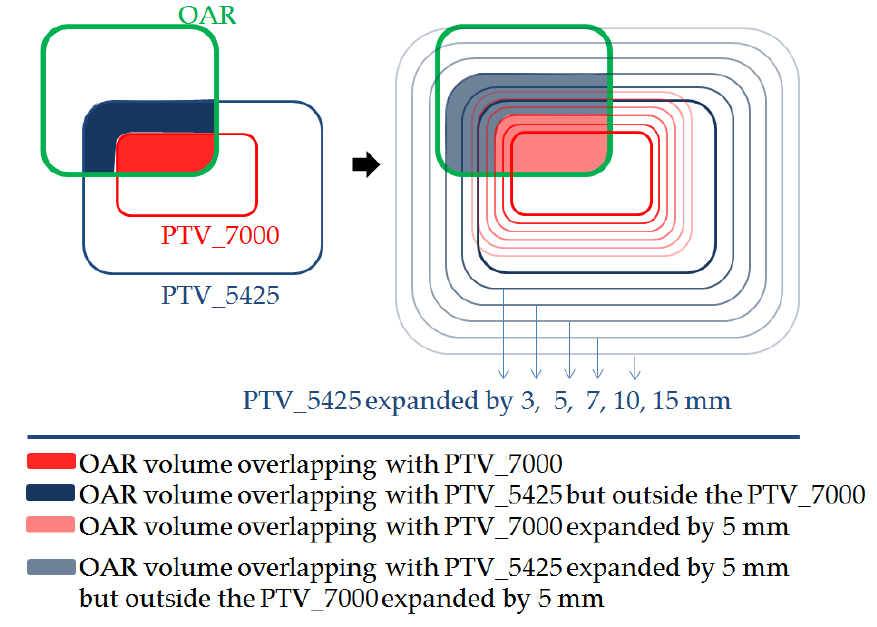
Figure 1. OAR volume overlapping with PTVs and PTVs expanded by different margins.